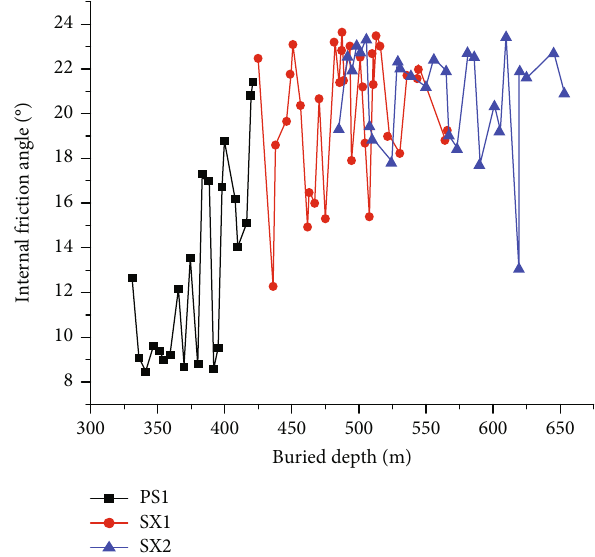
Figure 7: Curve of internal friction angle and depth of deep clay in